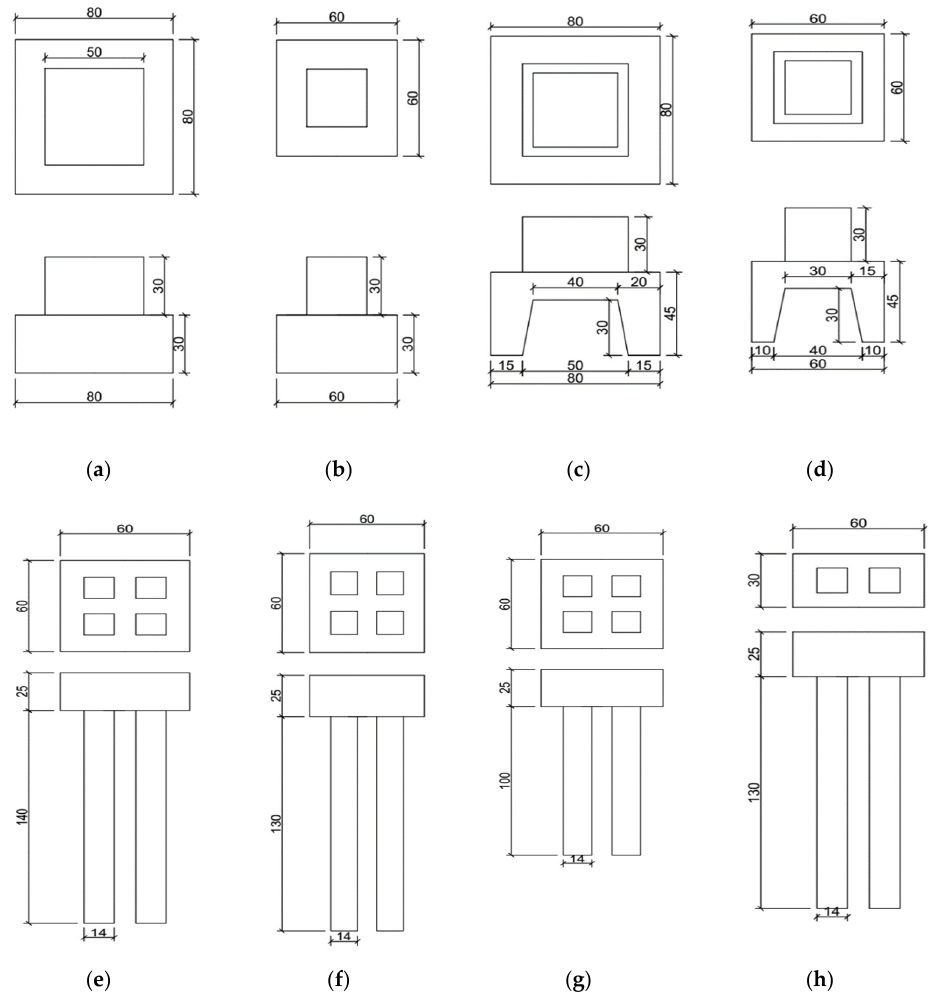
Figure 2. Dimensions of the eight fabricated test models (unit: cm). ( a ) Model S1; ( b ) model S2; ( c ) model C1; ( d ) model C2; ( e ) model P1; ( f ) model P2; ( g ) model P3; ( h ) model P4.